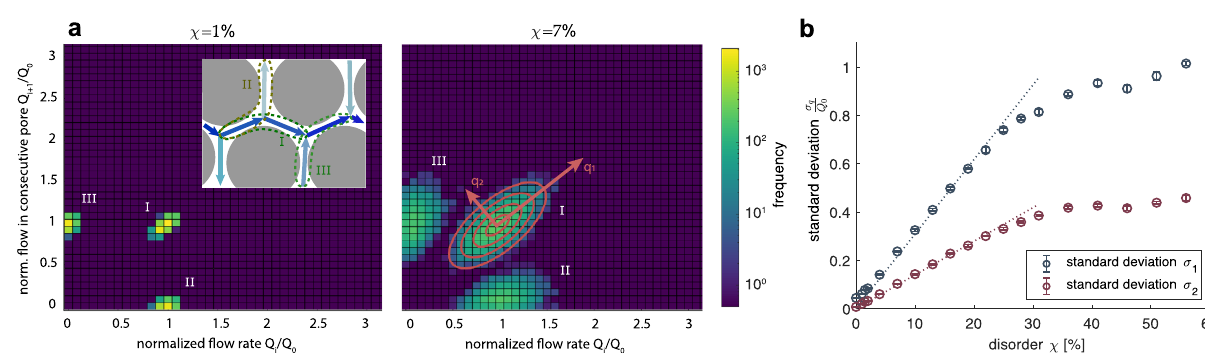
Fig. 3 | Flow statistics of porous media up to intermediate disorder are cap- tured by Gaussian statistics. a Flow statistics of consecutive pores. The statistics of fl ow in consecutive pores for low disorder ( χ =1%) and intermediate disorder ( χ =7%) are plotted, de fi ning the statistics of fl ow splitting at junctions. Flow sta- tisticsforporousmediawithahighdegreeofdisorderarefundamentallydifferent, see Supplementary Fig. S1. Q 0 denotes the average fl ow rate in parallel high- fl ow pores evaluated at χ =0%. For low and intermediate degrees of disorder three clusters are identi fi ed. Cluster I , containing information about the fl ow in con- secutiveparallelhigh- fl owpores,givesthefullinformationaboutthe fl owstatistics at junctions. Computing the covariance matrix, we fi nd that cluster I is well approximated by multivariate Gaussian statistics. The eigenvectors q 1 , q 2 are